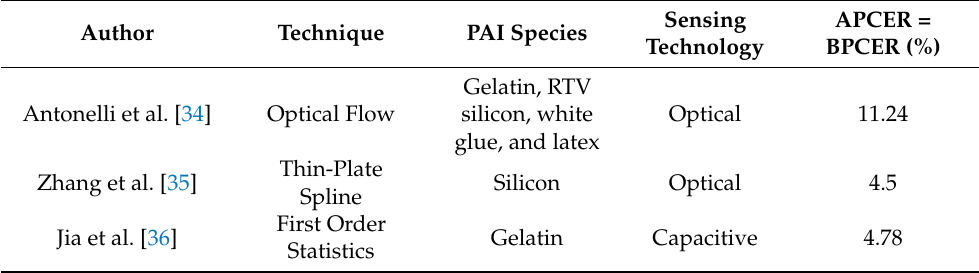
Table 1. Dynamic PAD mechanisms based on fingerprint deformation